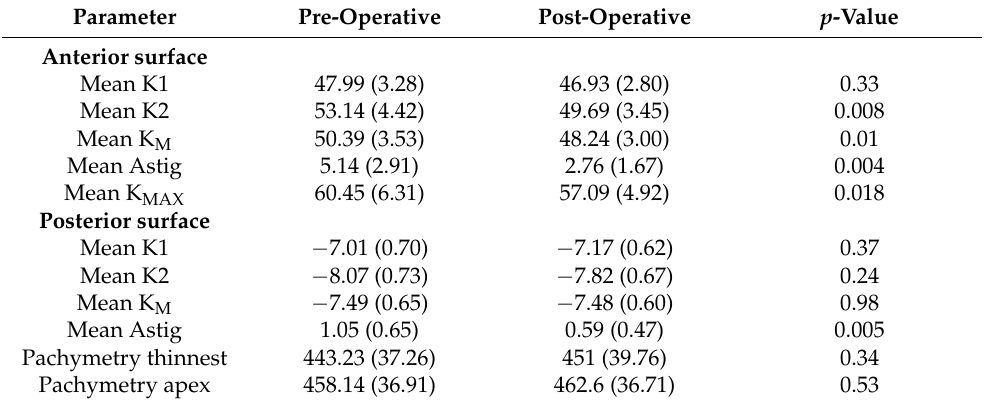
Table 3. Corneal tomographic changes in 21 keratoconic eyes implanted with Ferrara intrastromal corneal ring